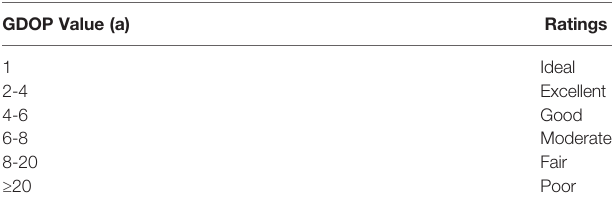
TABLE 6 | GDOP Ratings.